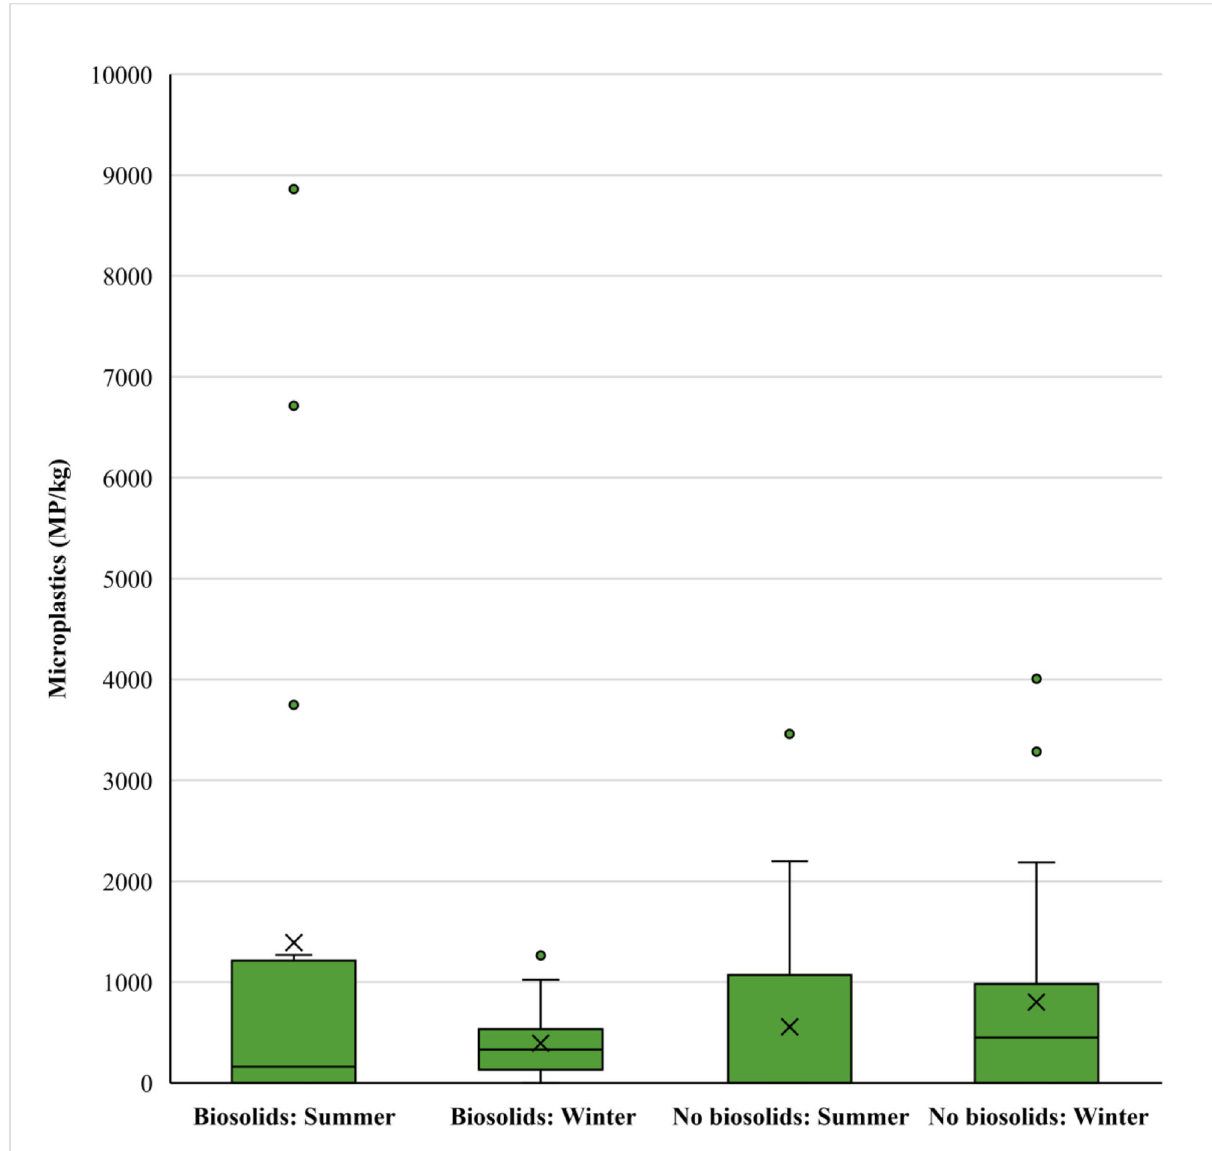
FIGURE 2 Microplastic concentrations in soils with and without biosolid application during summer (August 2019) and winter (February 2020) months shown as minimum, lower quartile, median, upper quartile and maximum values. Dots show values outside the interquartile